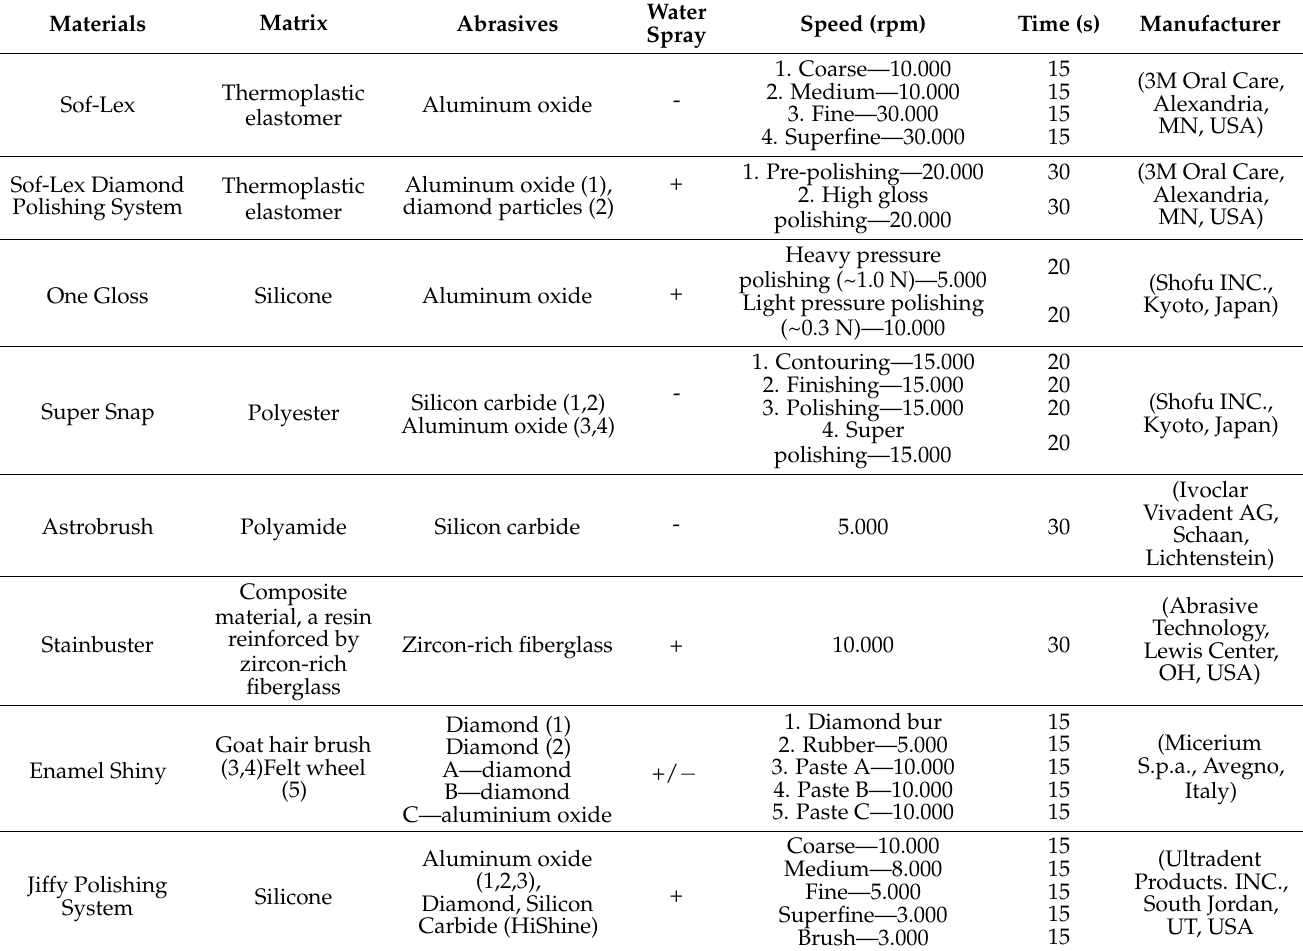
Table 2. List, composition and parameters used during application of the polishing